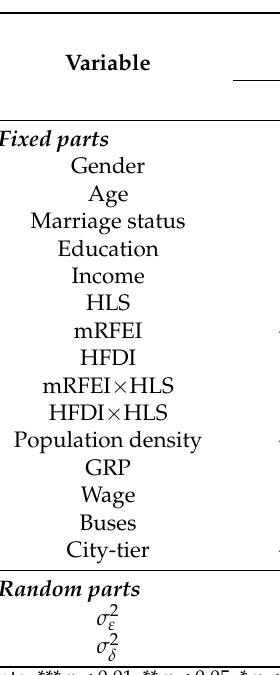
Table 4. Moderating effects of healthy individual